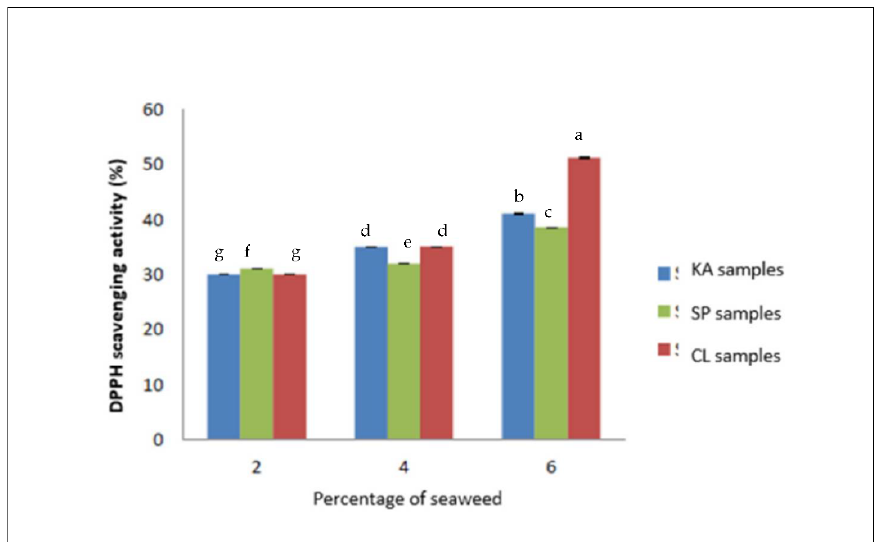
Figure 1. DPPH scavenging activity of all chicken sausage formulations. The different superscript alphabets ( a–g ) indicates there is a significant difference ( p < 0.05). alphabets ( a–g ) indicates there is a significant difference ( p <